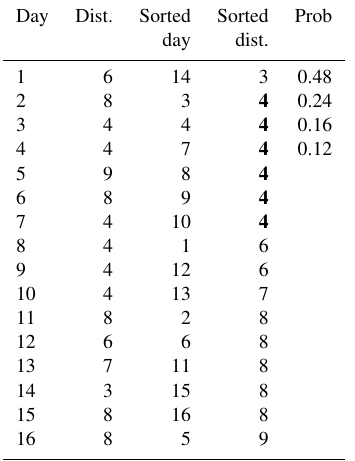
Table Appendix A3. Example for selecting one sequence for X c + 1 . The second row presents the distances in Table A2. The third and fourth columns show the sorted days and distances for the smallest distances to the largest in the second column. The fourth row presents the probabilities estimated with Eq. (12). Note that there are 6 days whose distances are identical. In this case, all the days are included, and among 6 days, one is selected with equal probabilities. The bold values are selected from the distance measurement in Eq. (11) and random selection in Eq. (12).